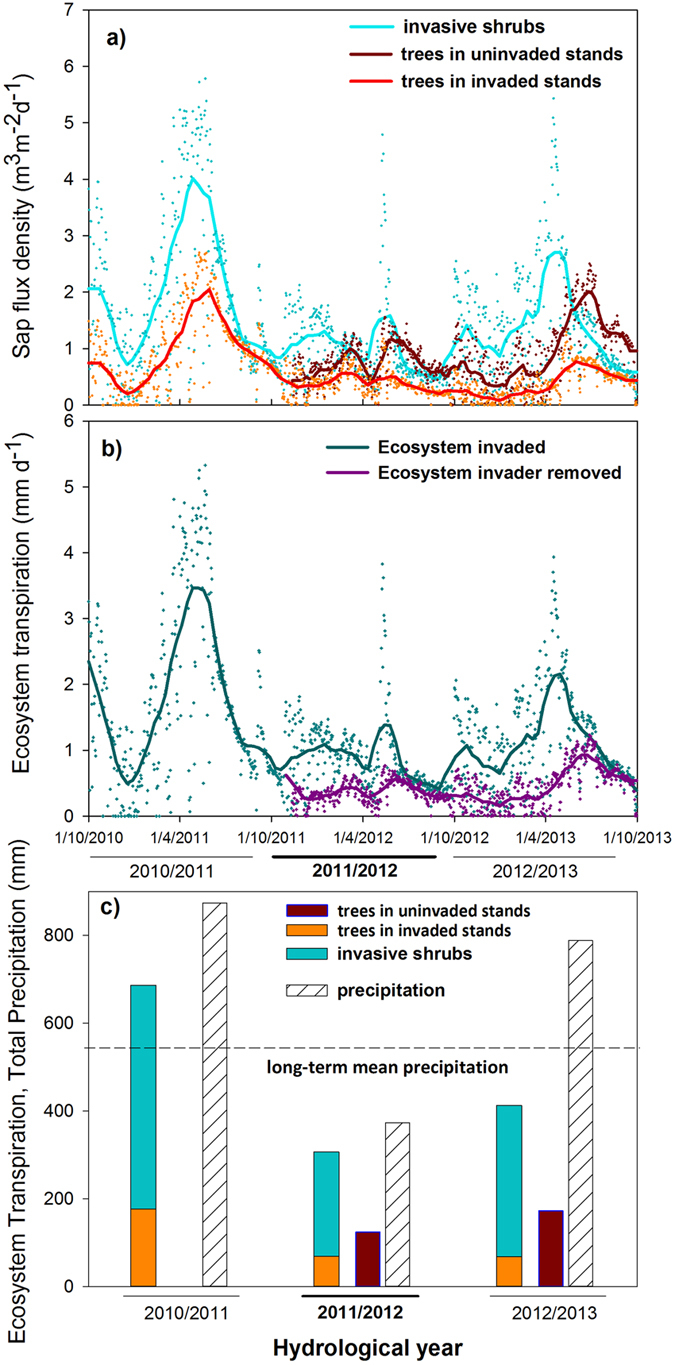
Effect of shrub invasion on ecosystem transpiration during the three hydrological years.(a) Daily sap flux density (i.e. water flux in the xylem) for the invasive Cistus ladanifer shrubs (cyan; n = 4); Quercus suber trees growing in shrub invaded stands (orange; n = 4) and trees after removal of the invader shrubs (uninvaded stands; n = 4) in Nov 2011 (dark red). (b) Ecosystem transpiration (mm d−1) for the invaded stands (green) and stands where the invader was removed (purple). Symbols mark daily sums, lines are best fit non-parametric smoothing kernel regression with a bandwidth of 0.25. (c) Precipitation and total annual ecosystem transpiration (mm y−1) for the invaded stands (stacked bars, equalling invasive shrub (cyan) and trees in invaded stands (orange) and for the uninvaded stands, where shrubs were removed in Nov 2011 (solely tree transpiration, dark red bars). Dash line indicates long-term mean precipitation.